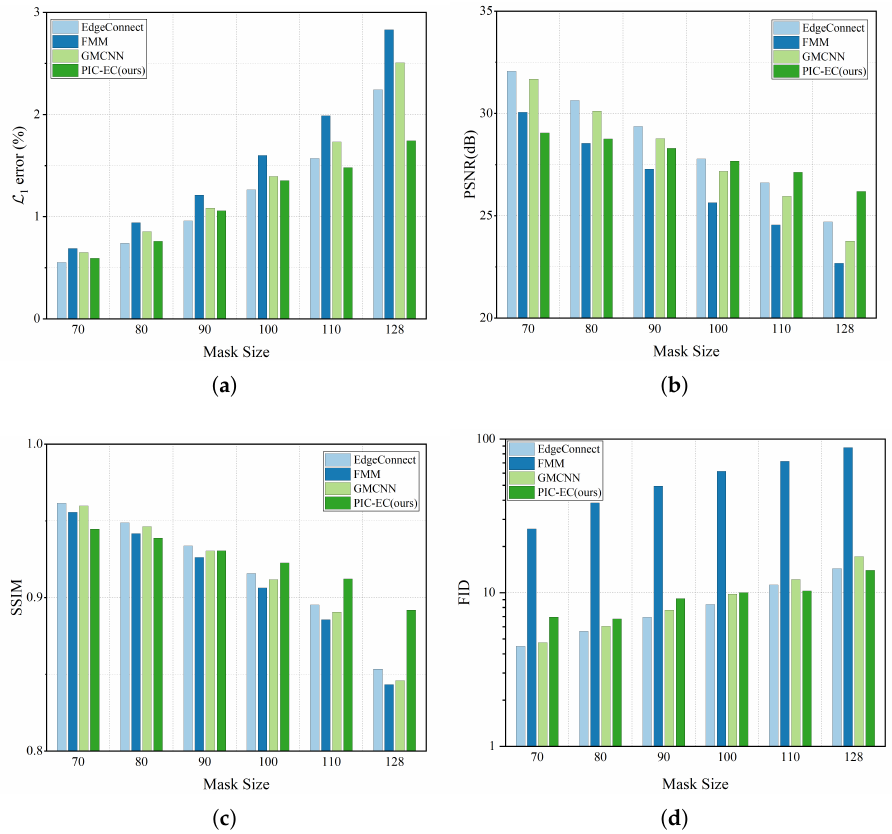
Figure 9. Effect of different masks over Paris StreetView. ( a ) results of (cid:96) 1 metric; ( b ) results of PSNR metric; ( c ) results of SSIM metric; ( d ) results of FID metric.